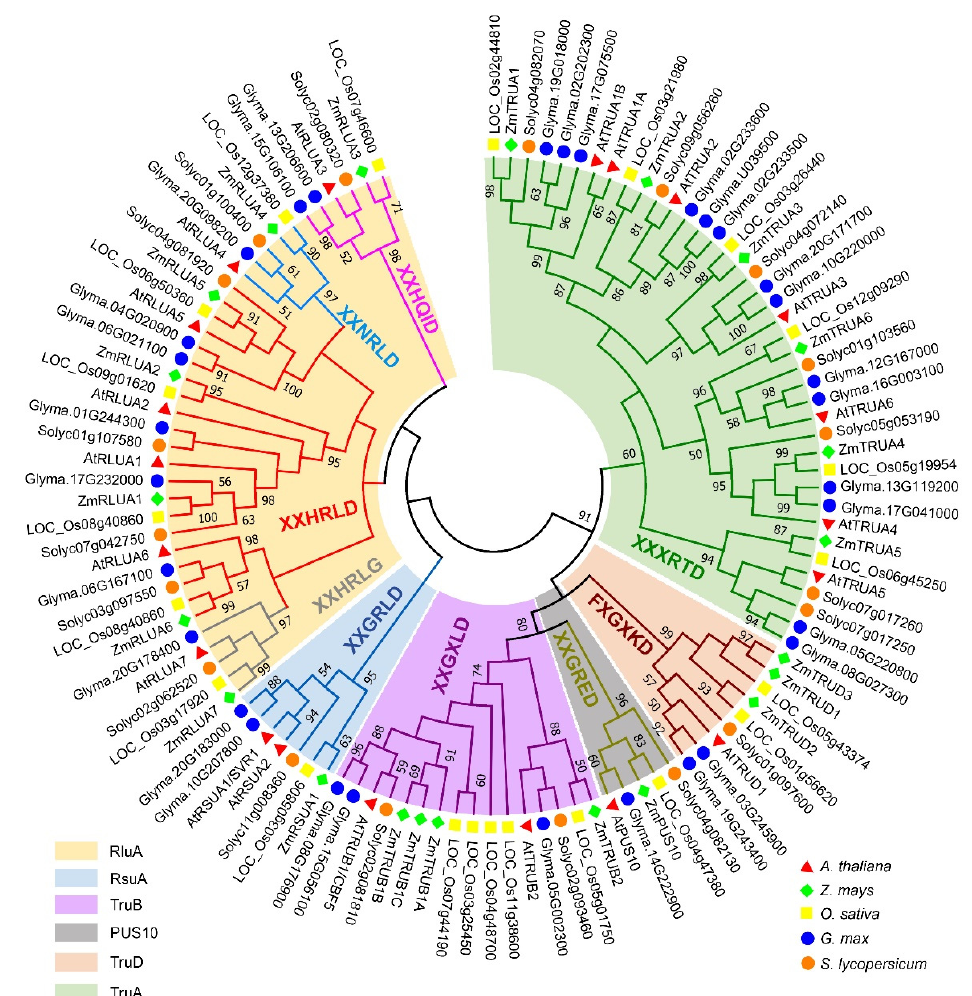
Figure 1. Phylogenetic tree of pseudouridine synthase family in several plant species. Evolutionary analyses were conducted by using the Maximum Likelihood method in MEGA7, based on the pseudouridine synthase domains of the PUS proteins from A. thaliana , Z. mays , O. sativa , G. max , and S. lycopersicum . The bootstrap consensus tree inferred from 500 replicates is taken to represent the evolutionary history of the taxa analyzed. The PUS members in the branches of phylogenetic tree covered by a colored panel belong to the same PUS subfamily as indicated and the sequences of the core six-amino-acid catalytic consensus sequence were shown, respectively.